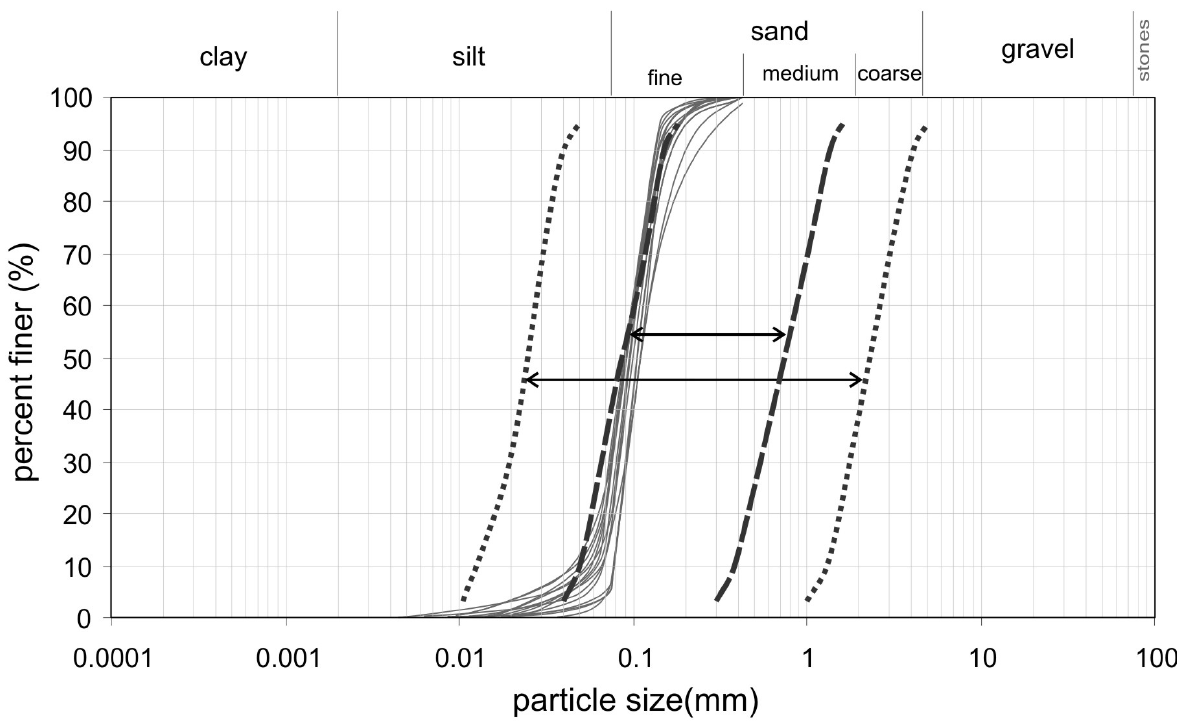
Figure 5. Comparison between the grain-size distribution curves of the collected samples and the boundary curves for liquefiable (dashed lines) and probable liquefiable (dotted lines) soils, as suggested by Tsuchida [1971]. Similar critical curves were proposed by EN 1998-1 [2004] and NTC